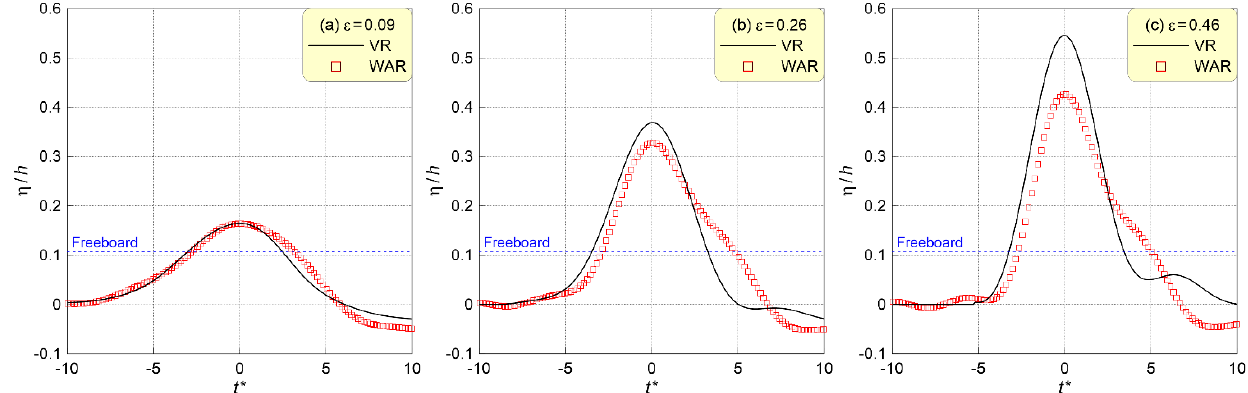
Figure 3. Comparisons of time-domain waveforms at the front of the VR and WAR.